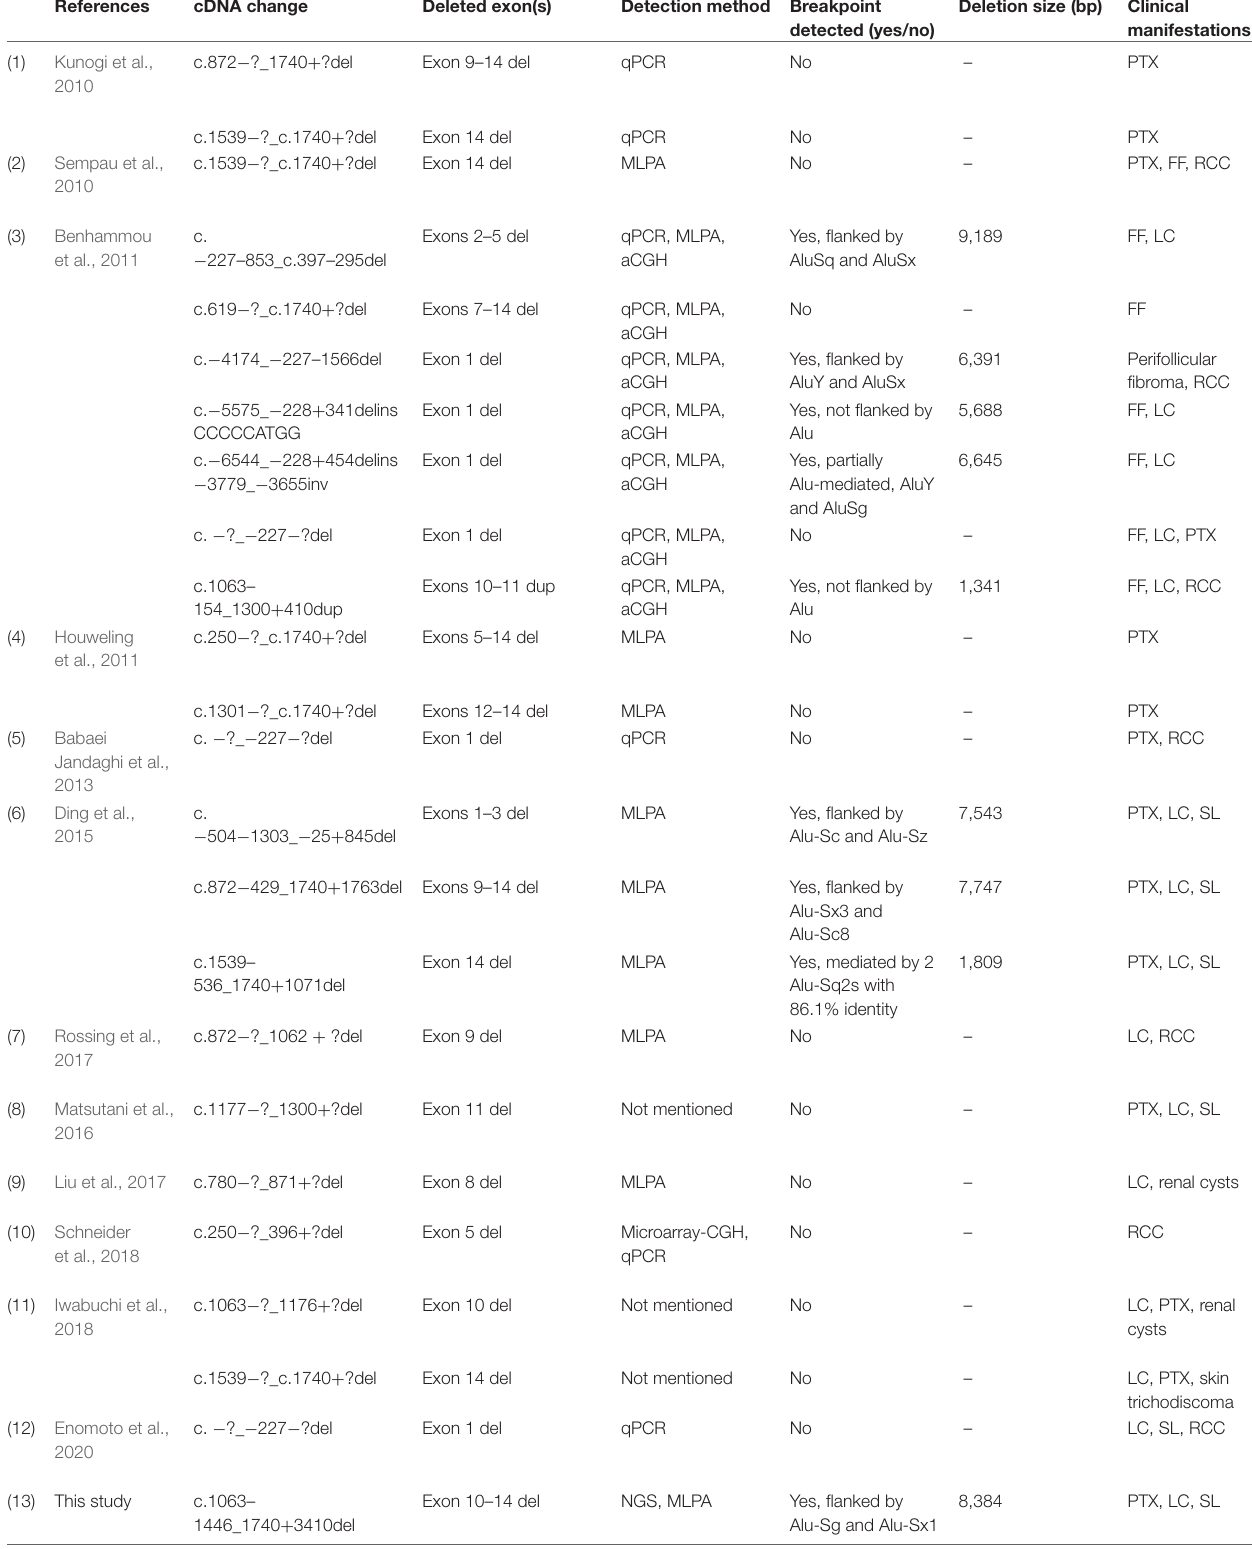
TABLE 1 | Previous and present reported FLCN intragenic